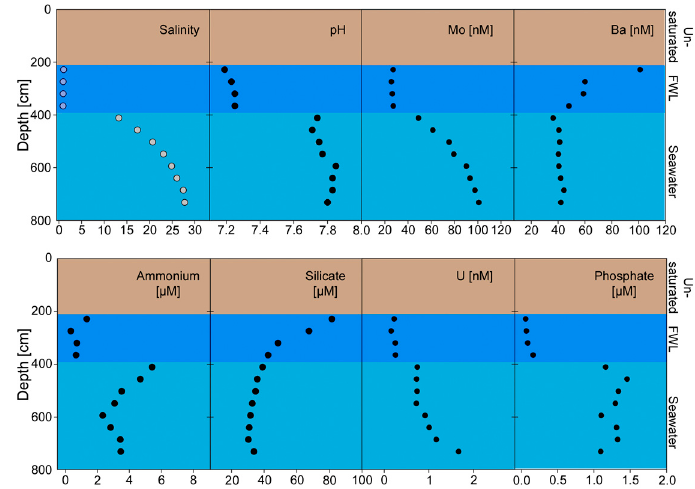
Figure 3. Geochemical pore water profiles demonstrating the sharp transition zone between the FWL and the underlying saline groundwater. Site location for these pore water profiles is indicated on Figure 2 between wells C1 and C2.